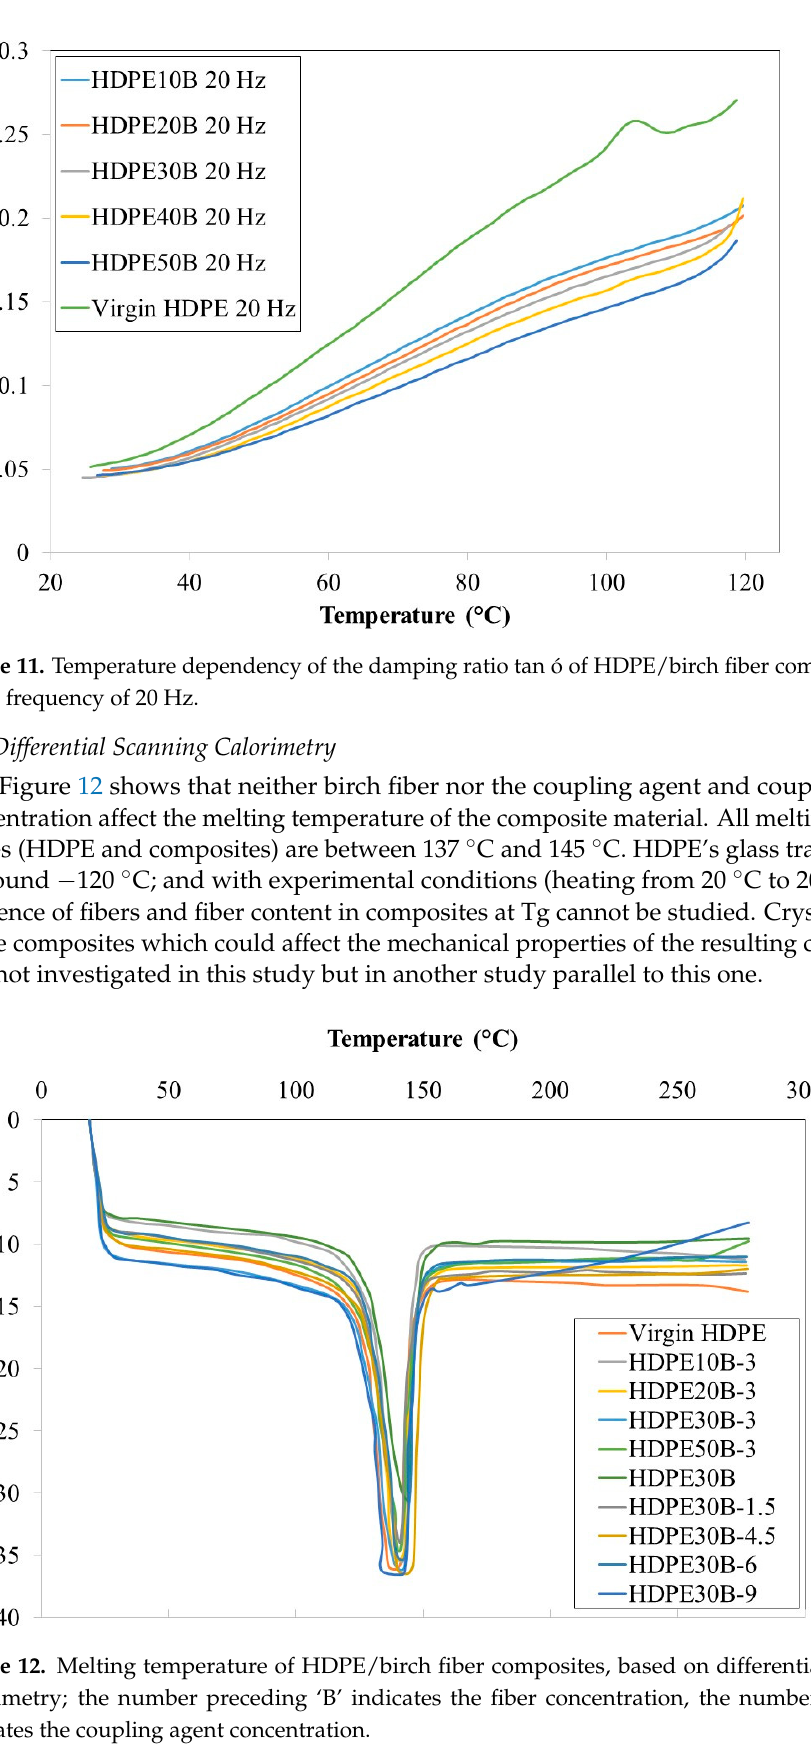
Figure 10. Temperature dependency of the damping ratio tan ό of HDPE/birch fiber com- posites at a stress frequency of 1 Hz.